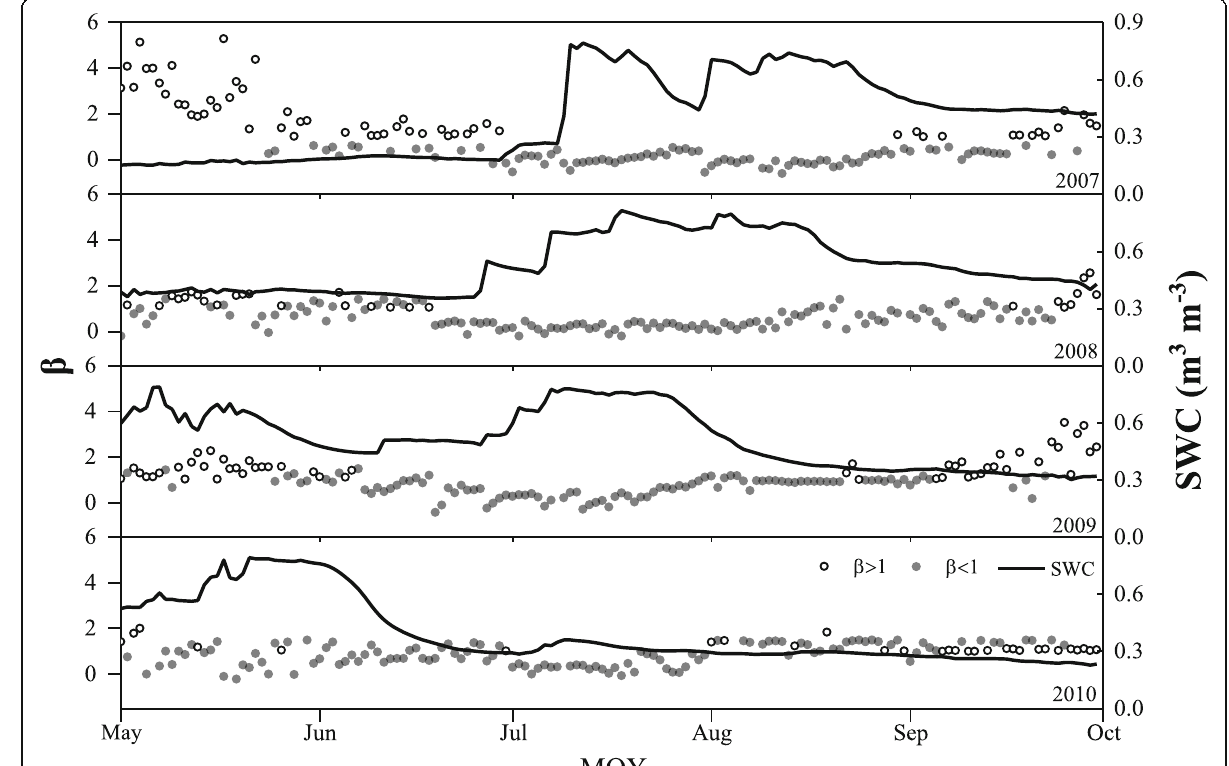
Fig. 9 Daily mean soil volumetric water content (SWC) and daily mean Bowen ration ( β ) in the meadow steppe during the four growing seasons of 2007 –